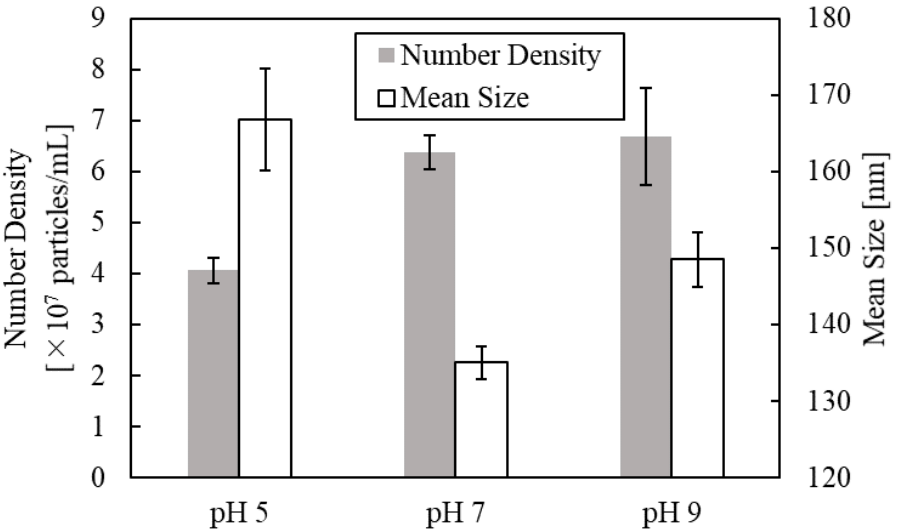
Figure 5. Number densities and mean sizes of the UFBs in the solutions with controlled pH values (5, 7, and 9; error bars indicate standard error). The bubbling time was fixed at 30 min.